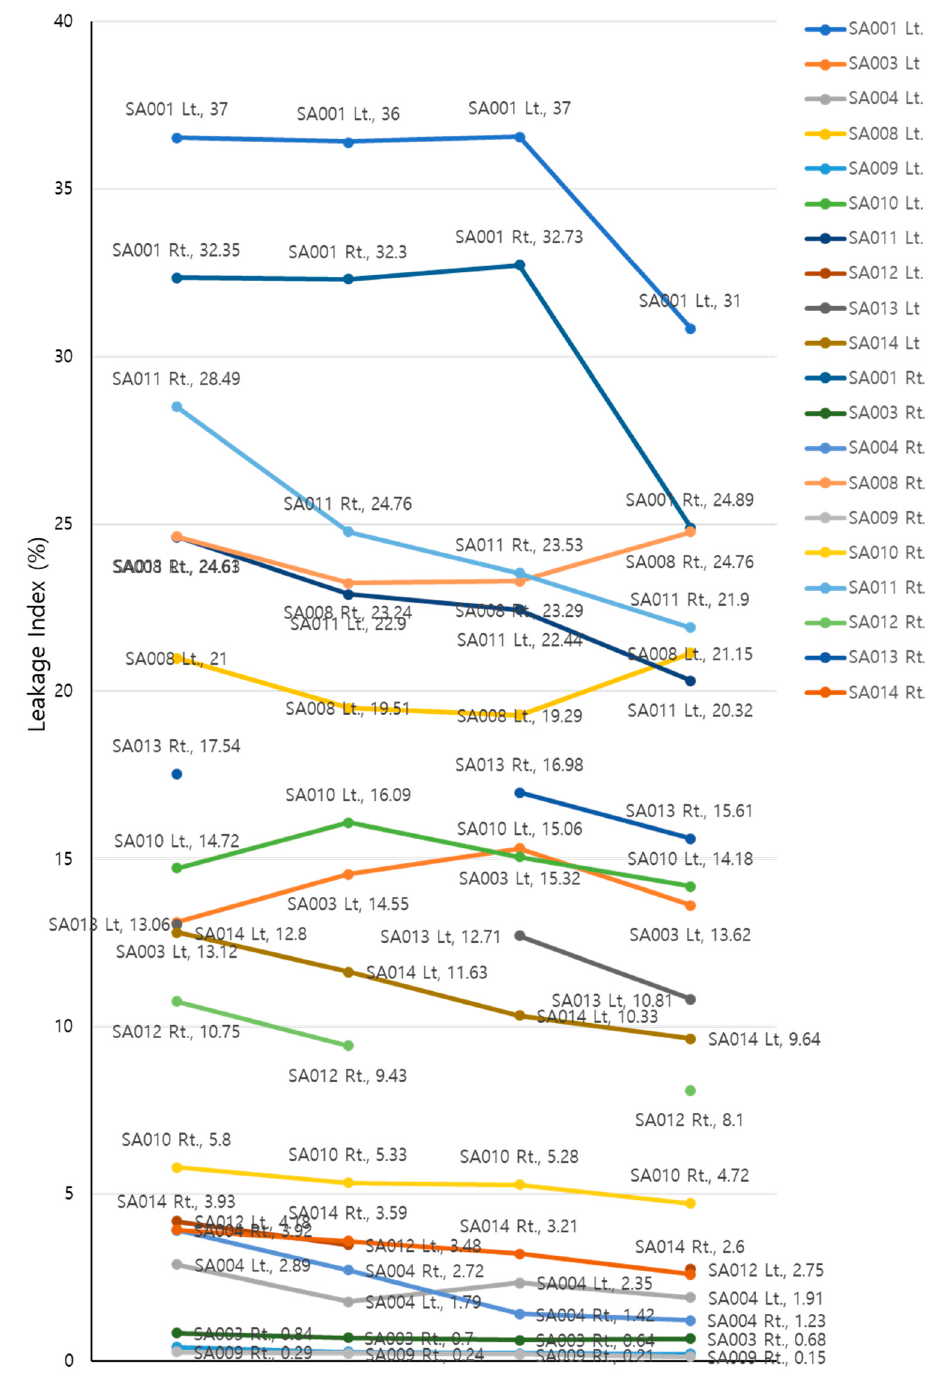
Figure 7. Changes in leakage indexes of the participants throughout the study period. To identify whether ischemic and leakage indexes were correlated at each time point, Spearman’s rank correlation test was conducted, as these indexes were not normally dis ‐ tributed (Shapiro–Wilk w = 0.7868, p < 0.0001 for ischemic index and w = 0.9167, p < 0.0001 for leakage index). The two indexes were moderately correlated (Spearman’s ρ = 0.3779, p = 0.0007; Figure 8).